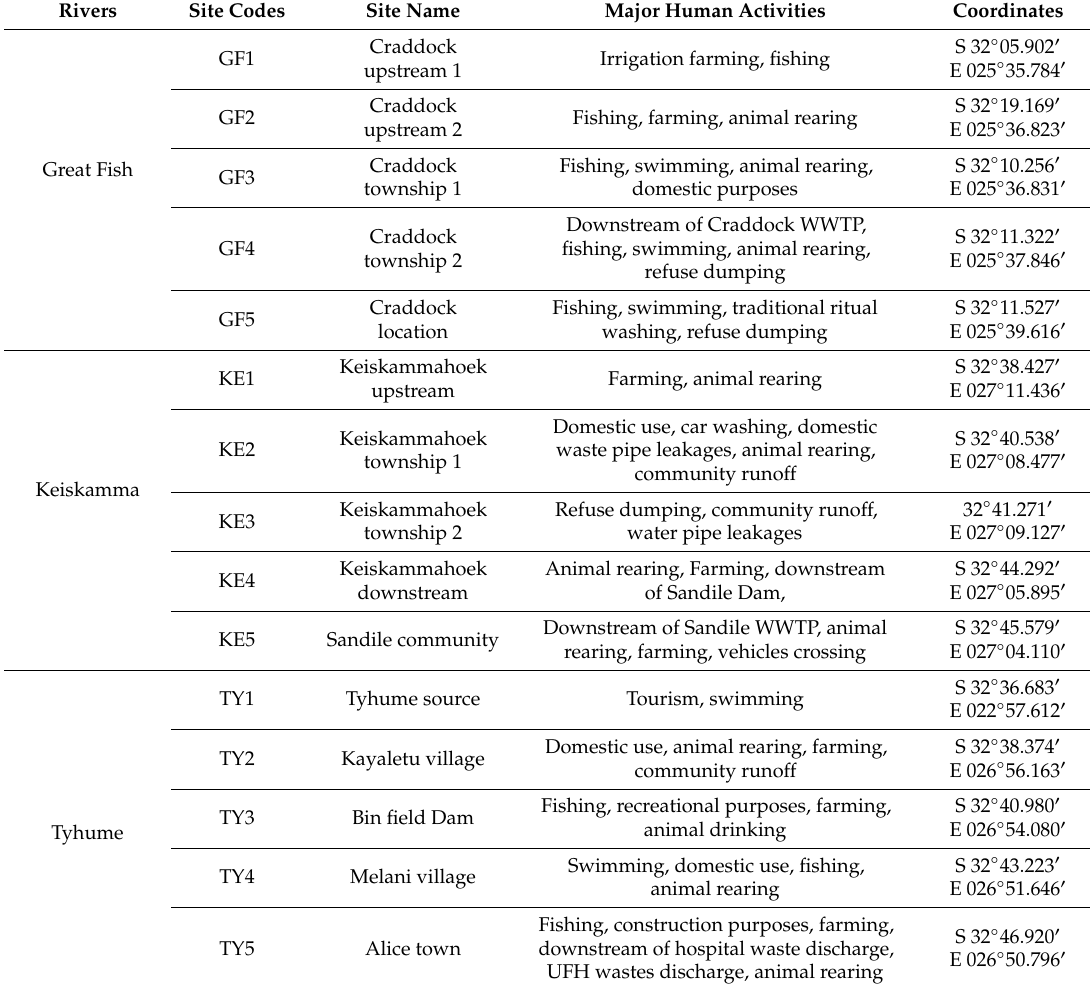
Table 1. Description of di ff erent sampling sites on the Great Fish, Keiskamma and Tyhume rivers.